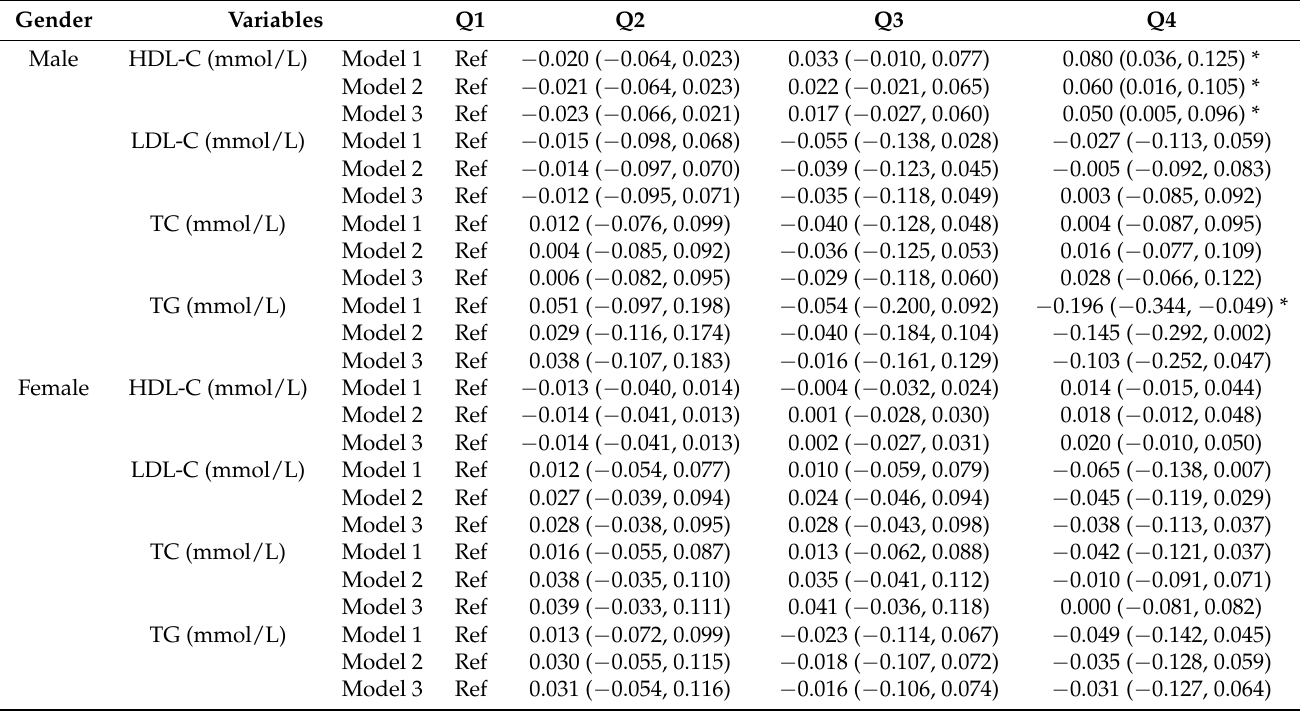
Table 2. Regression coefficients (95% CI) for serum lipid variables by quartiles of total physical activity in a Chinese sample population from nine provinces, CHNS